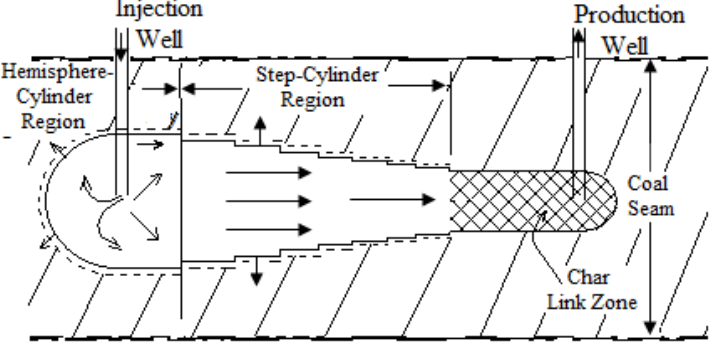
Figure 26. Conceptual sketch of the linked vertical well computer model geometry (redrawn from Eddy and Schwarz [57].